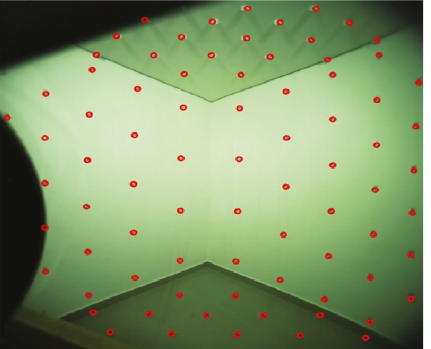
Figure 20: Example of capture performed in the calibration fi eld with the pod front camera used in the static ejection